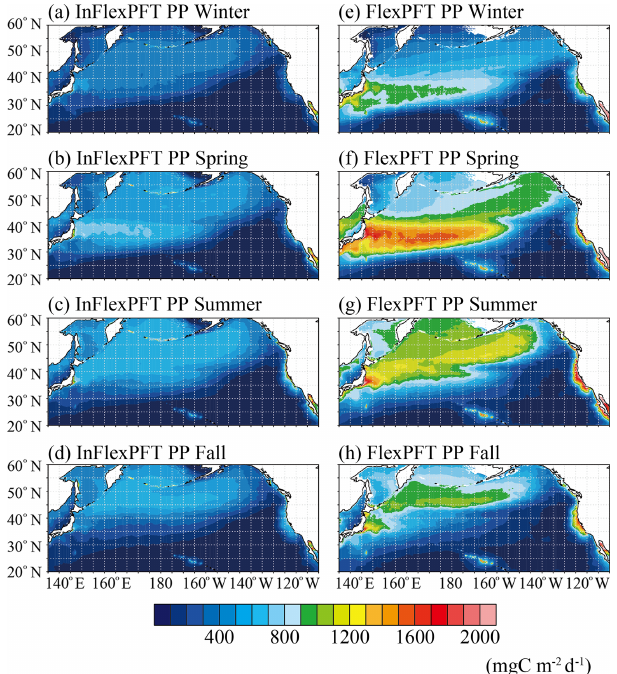
Figure 9. Climatological seasonal variations of primary produc- tion vertically integrated from the surface to 100m depth (mg Cm − 3 d − 1 ) from (a) – (d) the InFlexPFT and (e) – (h) the FlexPFT. The two models are averaged from 2000 to 2019 for each